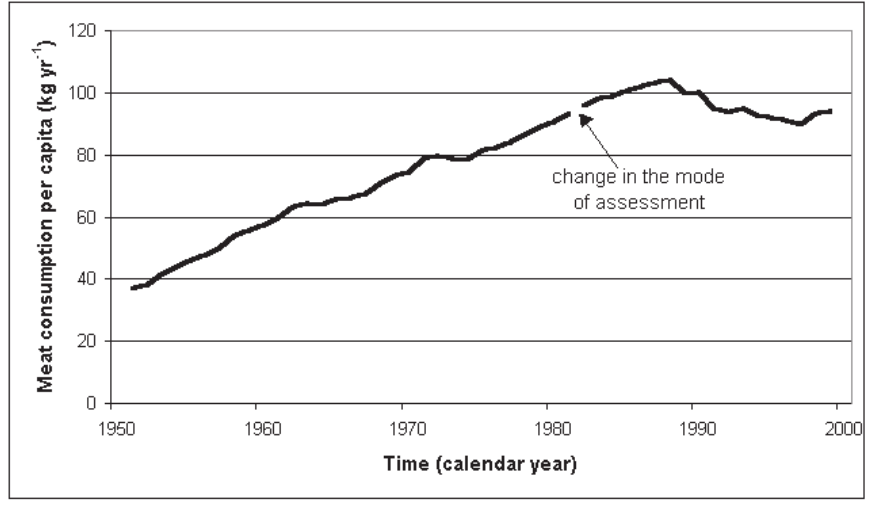
FIGURE 6. Postwar meat consumption (in kg year –1 per capita) in Germany; in the mid-1980s there was a change in the assessment mode